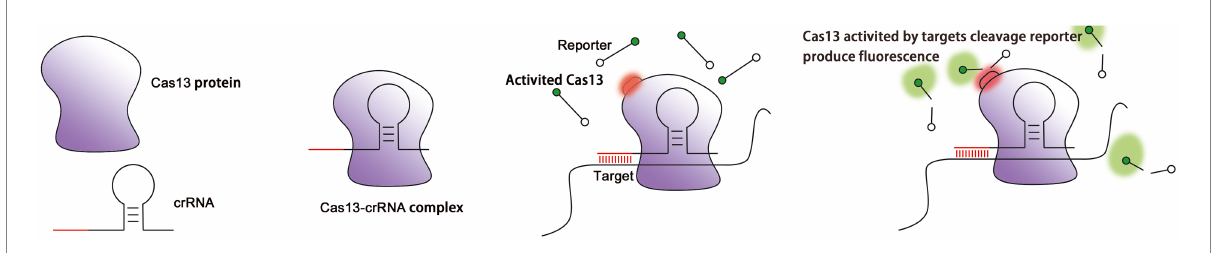
FIGURE 2 Cleavage of target RNA by the Cas13 protein as guided by crRNA. (A) The Cas13 protein localizes the target RNA under the guidance of crRNA. (B) Cas13 is activated after crRNA finds and binds to the target RNA (red circle: the structure of HEPN subunit of Cas13 protein changes). (C) Activated Cas13 cleaves the target RNA. (D) Activated Cas13 not only cleaves the target RNA, but also randomly cleaves other nearby RNAs in a collateral effect. This effect can be detected via reporter RNAs with fluorescent and quenching groups at both ends (green: fluorescent